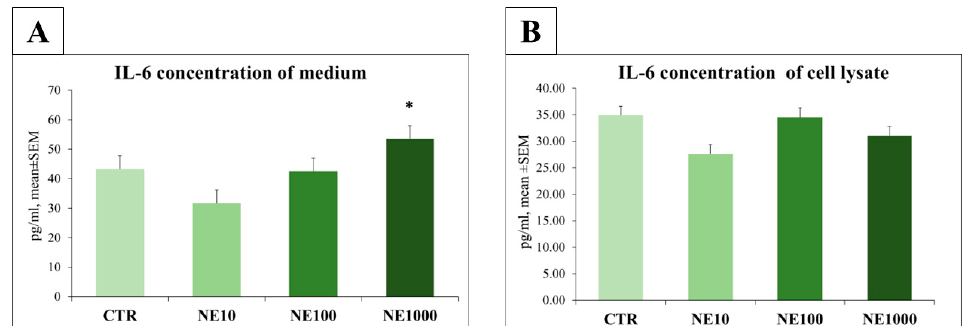
Figure 7. Interleukin-6 (IL-6) concentrations in culture media ( A ) and cell lysate ( B ) after 1-h nore- pinephrine (NE) treatment. CTR = non treated control cells, NE10 = 10 µM norepinephrine treated cells, NE100 = 100 µM norepinephrine treated cells, NE1000 = 1000 µM norepinephrine treated cells. n = 6/group, results are expressed as mean ± SEM, * p < 0.05. 1000 µ M NE exposed cells in comparison with the controls ( p = 0.012, p = 0.009, p < 0.001,